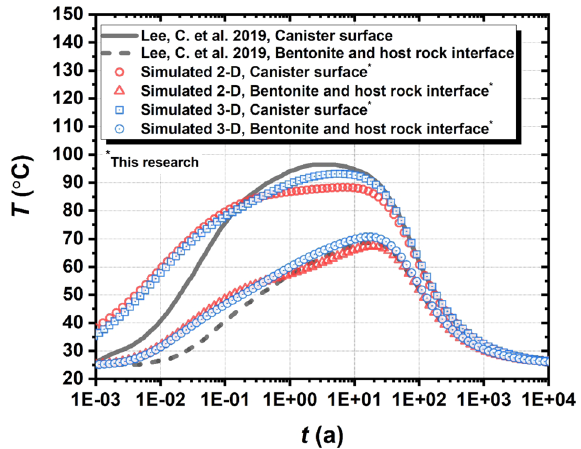
Fig. 8 Validation of temperature pro fi le. Comparison of tempera- tures ( T ) between Lee et al. and our model for canister/bentonite and bentonite/host rock interfaces 35 .